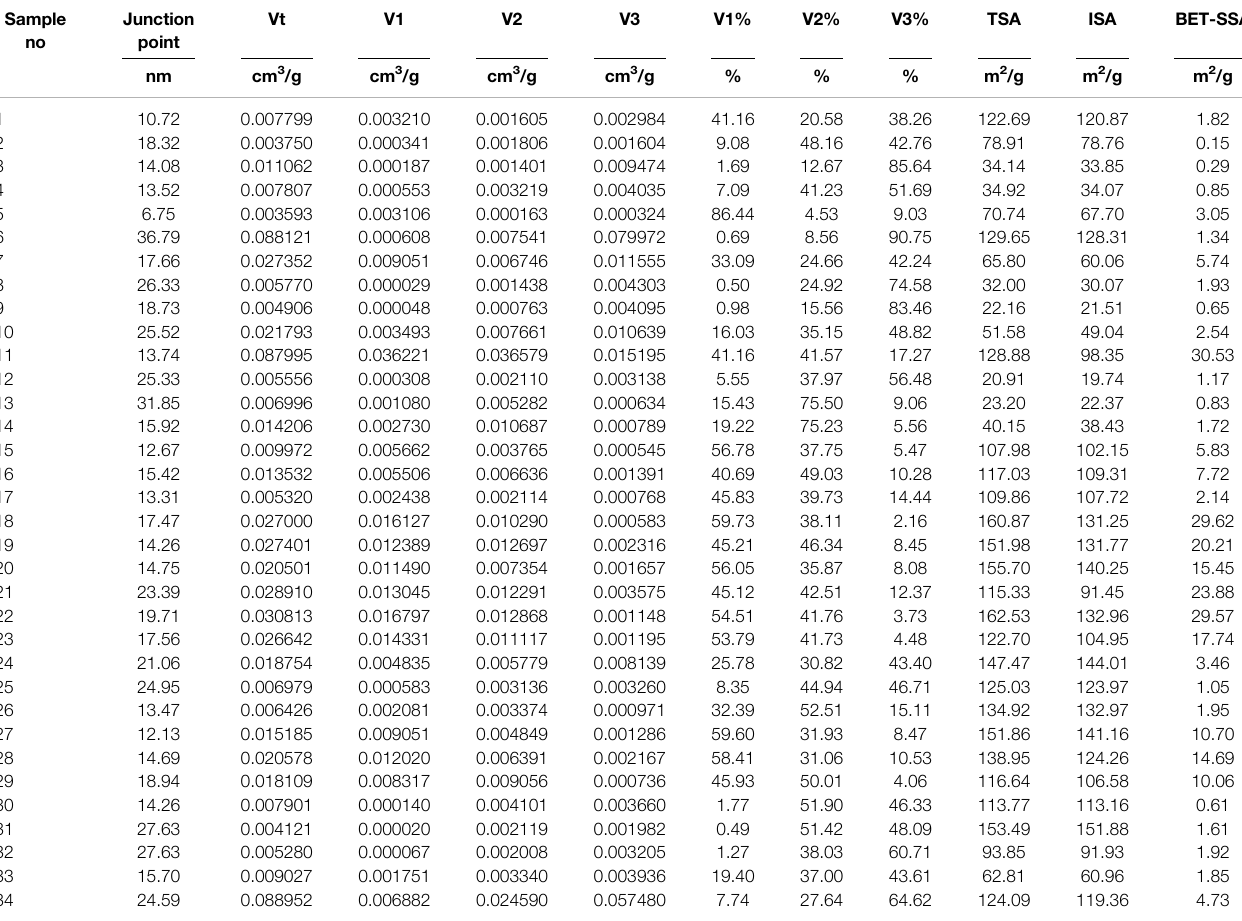
TABLE 2 | Junction points, pore volumes and contents, surface